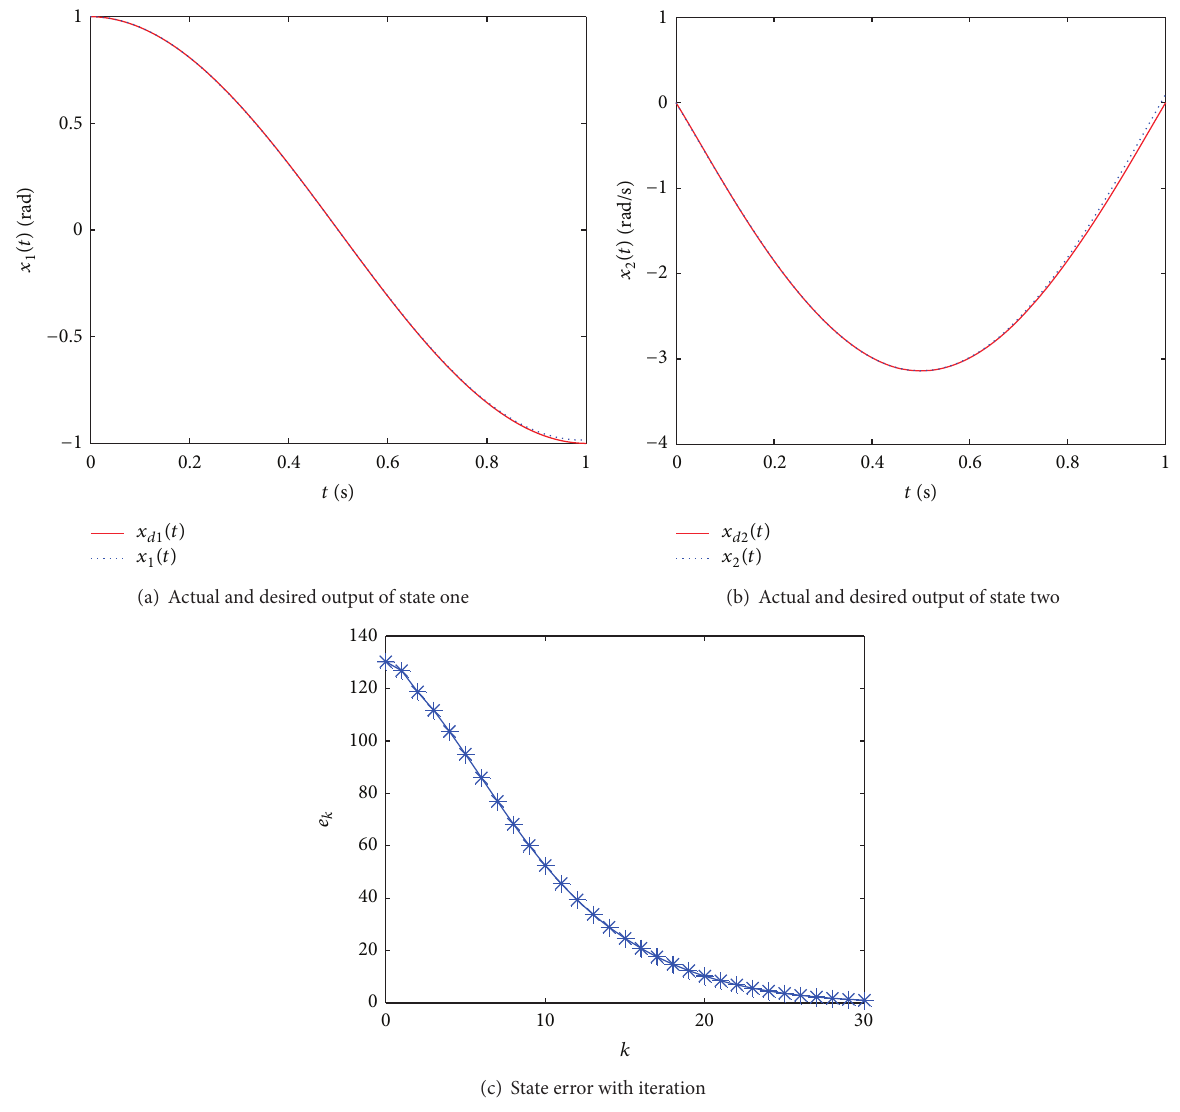
Figure 2: Single model ILC when 𝑑 𝑘 (𝑡) =